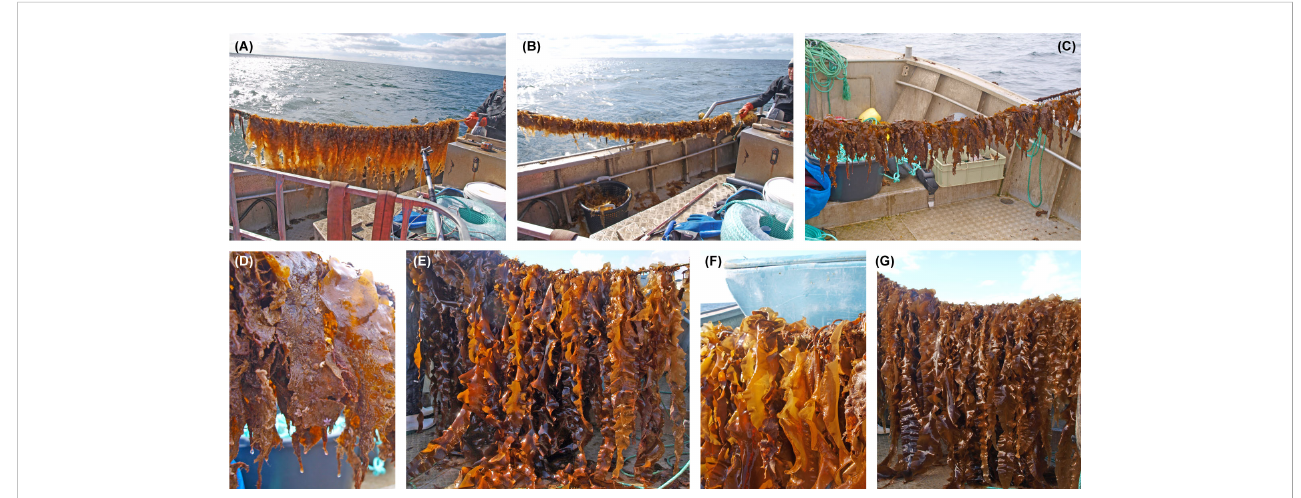
FIGURE 9 Pictures of the vertical lines deployed in October 2018: (A) Line before coppicing in May 2019, (B) same line just after coppicing in May 2019, (C, D) line upon measurement in October 2019, (E, F) line upon measurement in April 2020. (G) Picture of the vertical lines deployed in October 2019 upon measurement in April